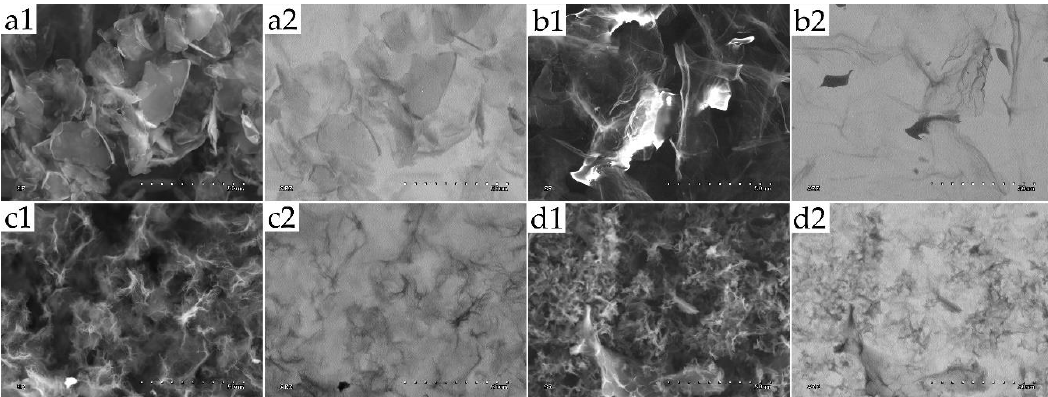
Figure 1. Morphology of GN and rGOs was examined using a scanning electron microscope (SEM). ( a1 ) GN/ExF, ( b1 ) rGO/Term, ( c1 ) rGO/ATS, ( d1 ) rGO/TUD—standard SEM images show 2D nanosheets morphologies. Scale bare: 50 µm. ( a2 ) GN/ExF, ( b2 ) rGO/Term, ( c2 ) rGO/ATS, ( d2 ) rGO/TUD—AEE mode showing conductive materials. Scale bare: 50 µm. Abbreviations : GN, graphene; rGO, reduced graphene oxide; SEM, scanning electron microscope; AEE, active emission element; ExF, exfoliation; Term, thermal; ATS, ammonium thiosulphate; TUD, thiourea